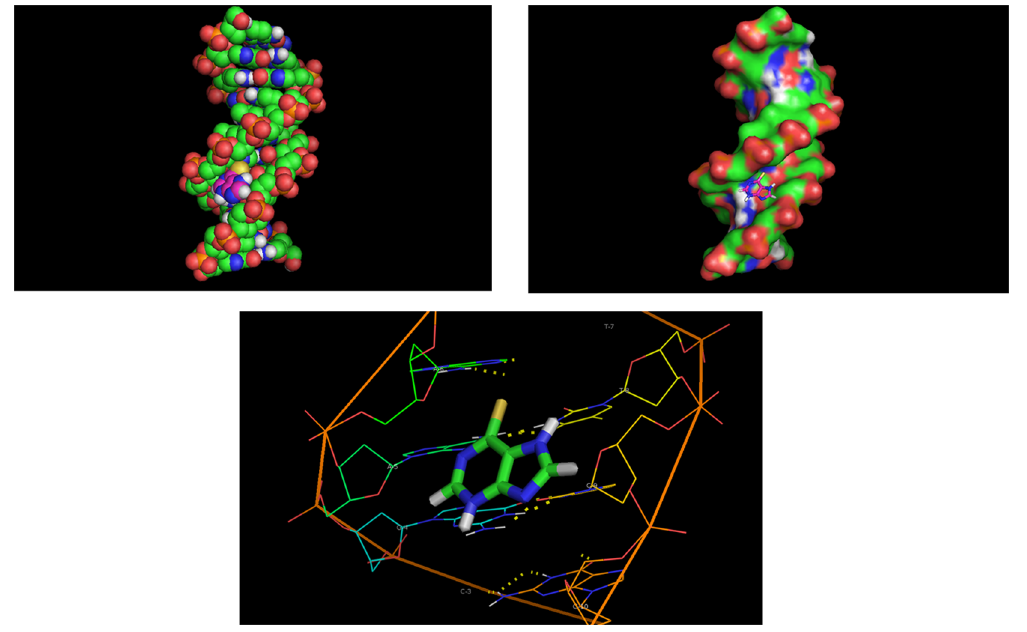
Figure 9. Molecular docked structure of 6MP complex with DNA. Dodecamer duplex sequence (CGCGAATTCGCG) 2 (PDB ID: 1BNA) was used in the docking studies. The binding energy of the complex system was found to be 2 116.97 kJ/mole.